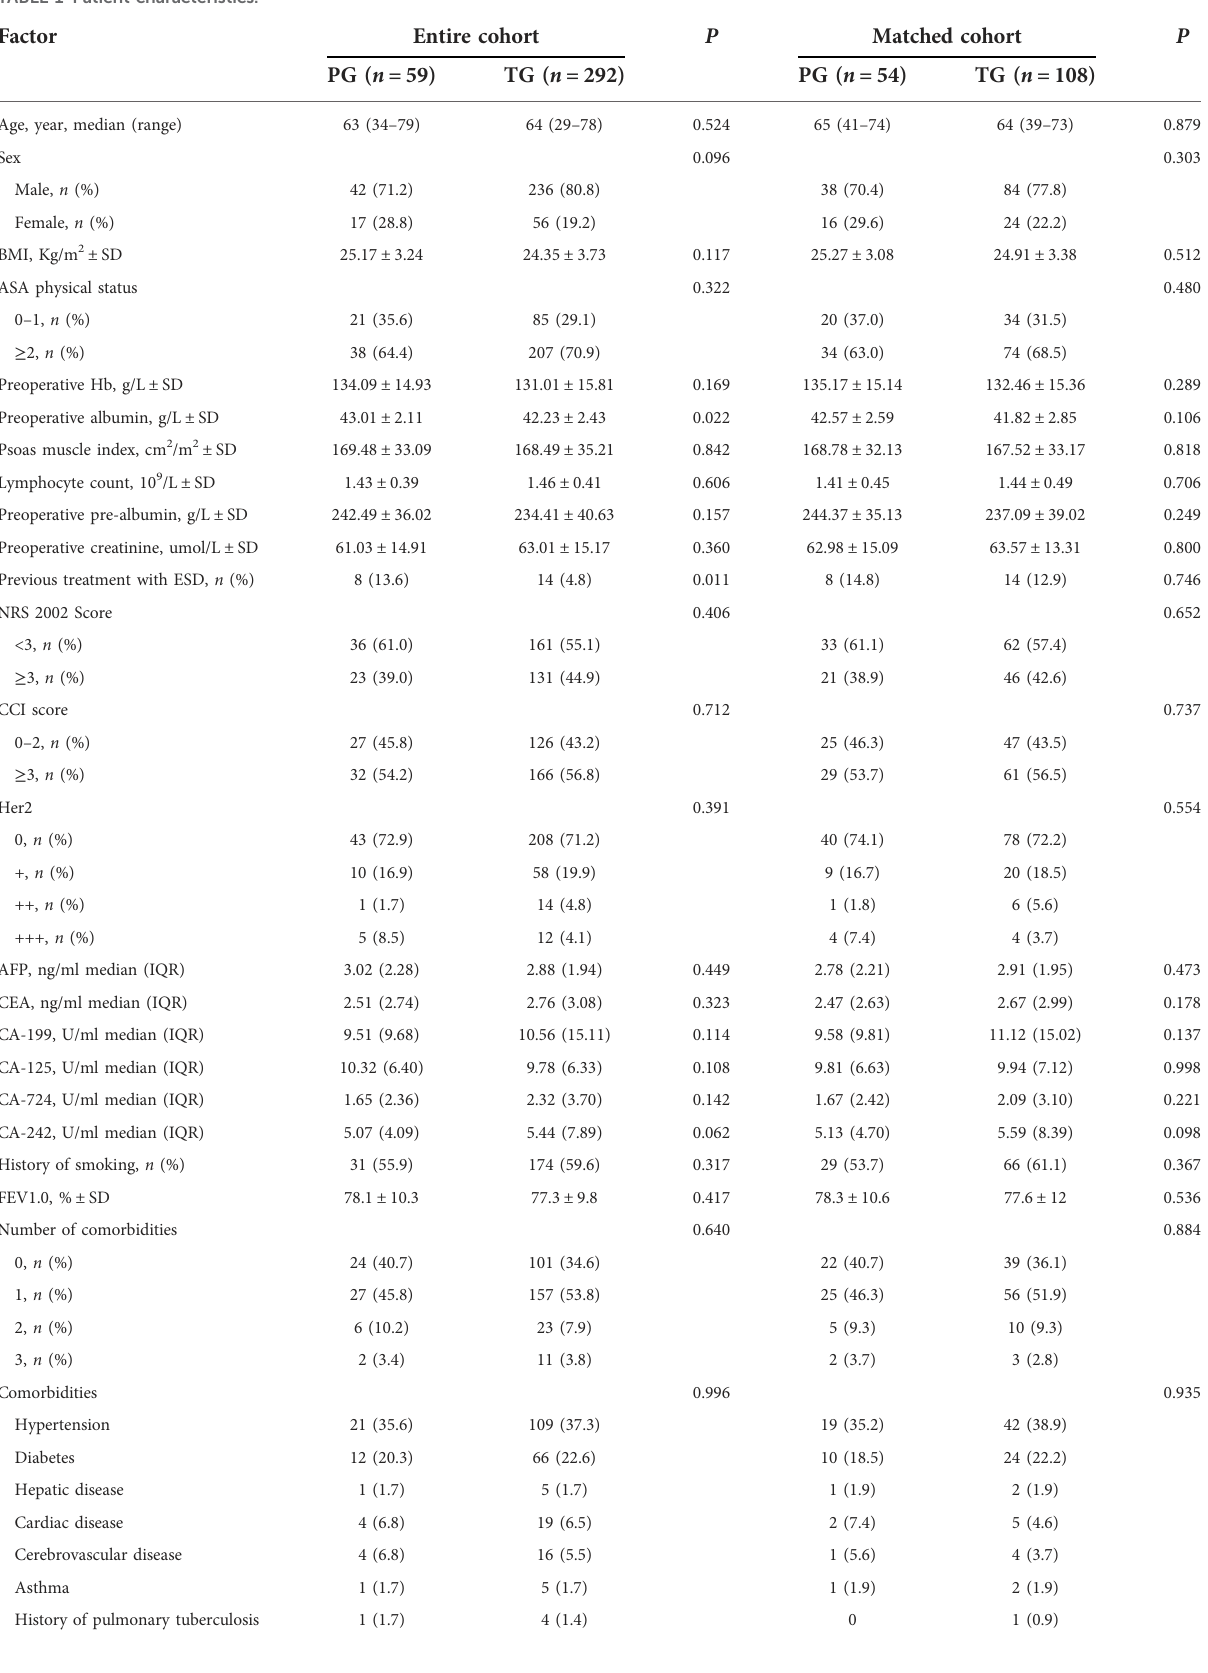
TABLE 1 Patient